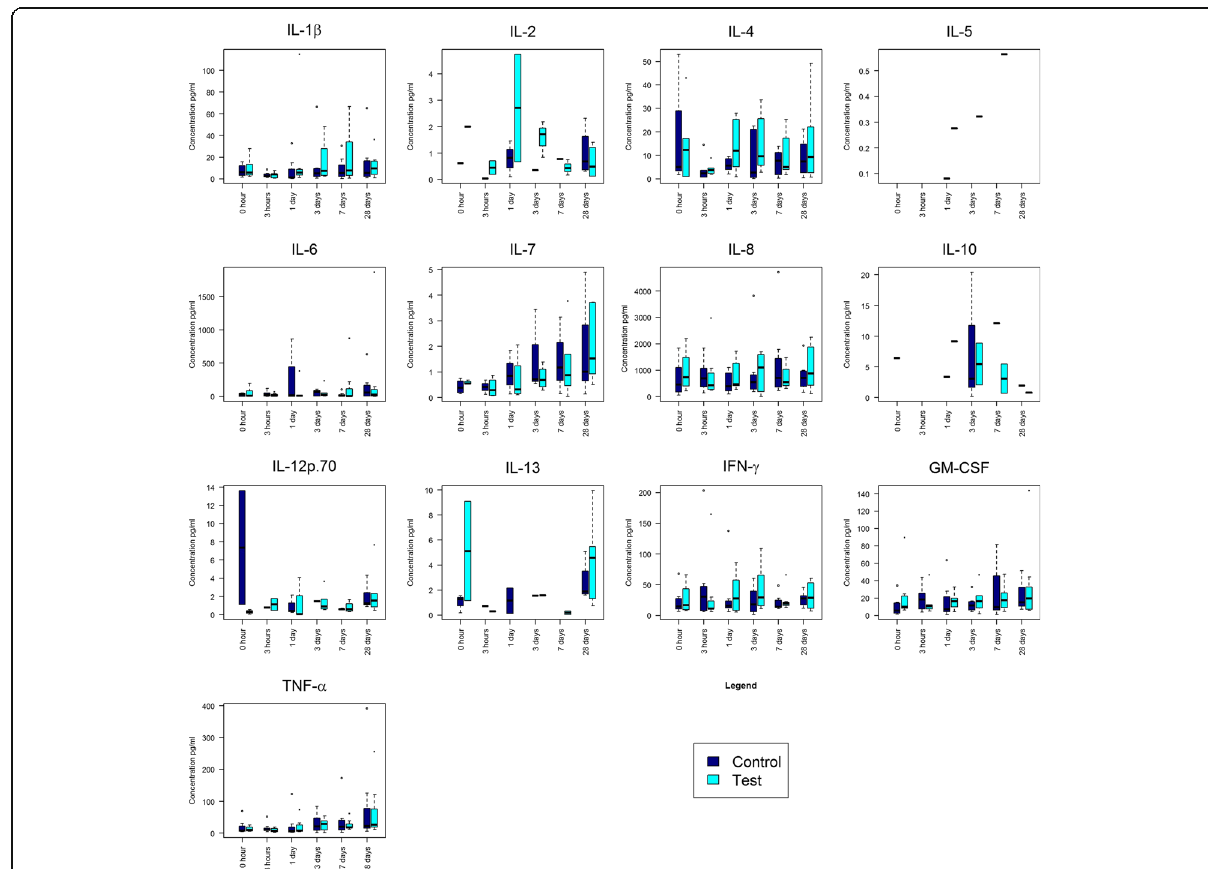
Fig. 2 Box plot distribution of raw data for GCF cytokines by time and treatment, separately for each cytokine. The horizontal line within the box plot represents the median, vertical line from the boxes ( whiskers ) indicating variability outside the upper and lower quartiles; squares and circular points represent the observation point (outliner)